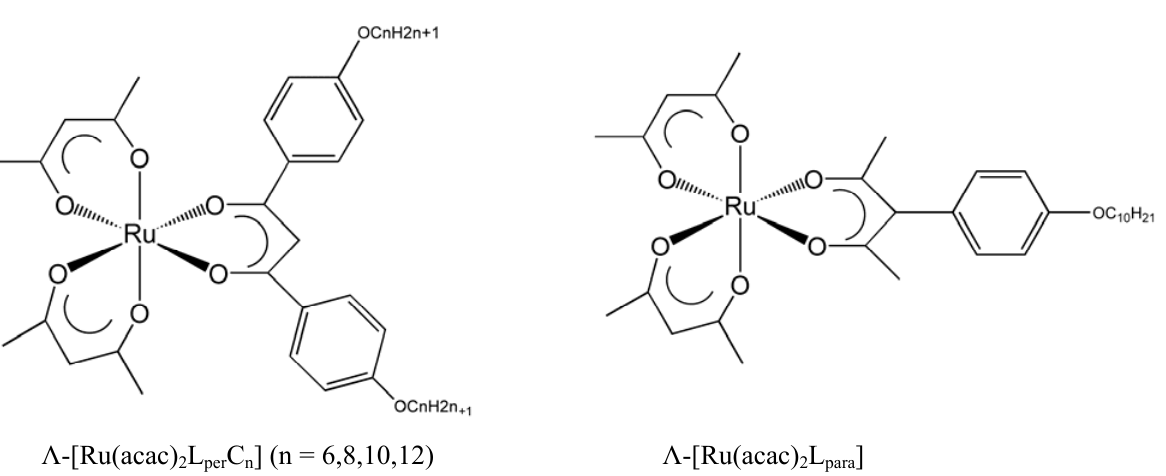
Figure 2. CD spectra of enantiomers in methanol (left) [Ru(acac) [Ru(acac)